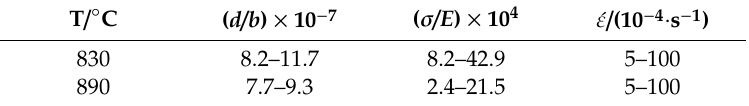
Figure 11. Deformation mechanism maps for Ti alloy at ( a ) 830 ◦ C and ( b ) 890 ◦ C. Table 5. Calculated results for hot compression deformation of the Ti–6Al–4V